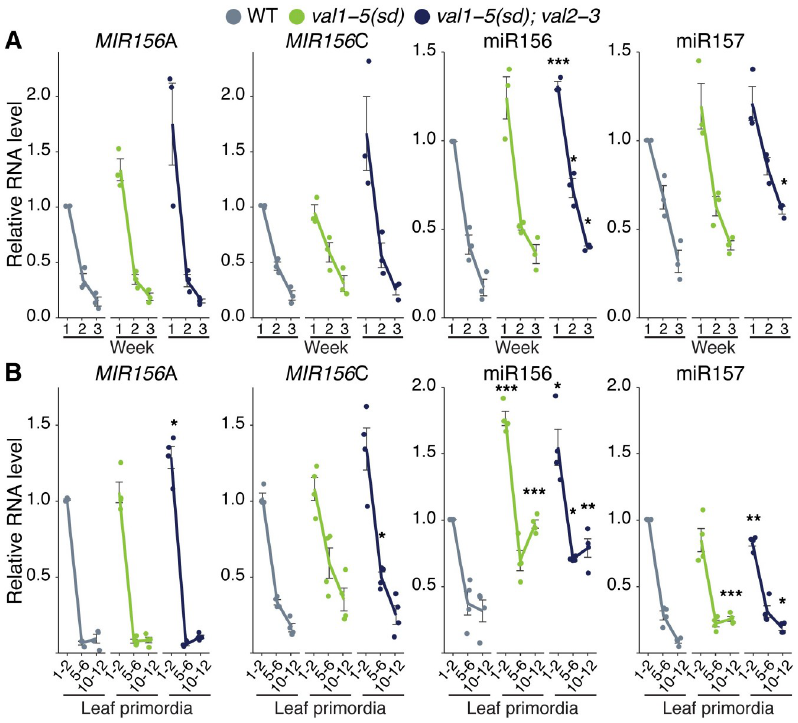
Fig 2. VAL genes function predominantly as quantitative regulators of miR156 expression. (A, B) qRT-PCR analyses of gene expression. (A) Shoot apices with leaf primordia (LP) � 1mm removed at 1, 2 and 3 weeks. (B) Isolated LP 0.5-1mm in size. All plants were grown in SD conditions. Each data point represents a biological replicate and is the average of three technical replicates. Coloured lines represent the mean and black bars mean ± s.e.m. Asterisks represent significant differences between WT and val mutants at the same time point, calculated by an unpaired two-tailed t- test with a Bonferroni correction for multiple comparisons ( � P < 0.025; �� P < 0.005; ��� P <